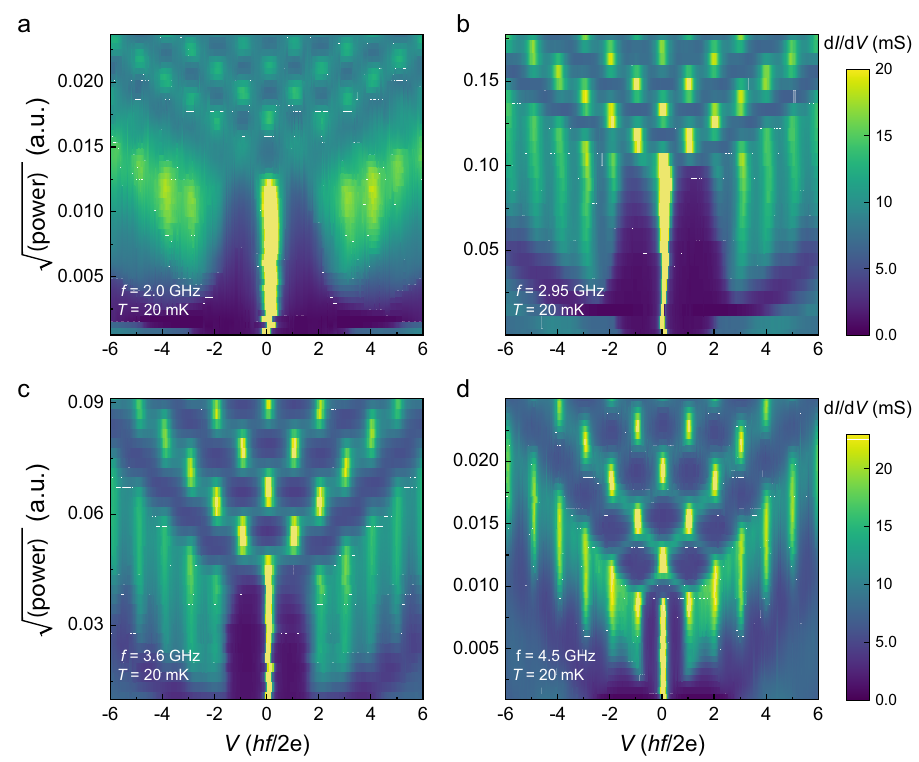
Fig. 3 Shapiro response of device 1 at various rf frequencies. a – d Mapping of d I /d V measured under the irradiation of rf waves at various frequencies (2.0, 2.95, 3.6, and 4.5 GHz) as functions of rf excitation and the dc voltage V appearing on the JJ, which is normalized by hf /(2 e ) to emphasize the Shapiro-step nature of the response. When there is a plateau (Shapiro step) at V m in the V vs. I bias curve, the slope of the curve, d V /d I , becomes zero at the plateau, which means that d I /d V diverges at V m ; therefore, the yellow vertical lines occurring at regularly-spaced V is the signature of Shapiro steps.